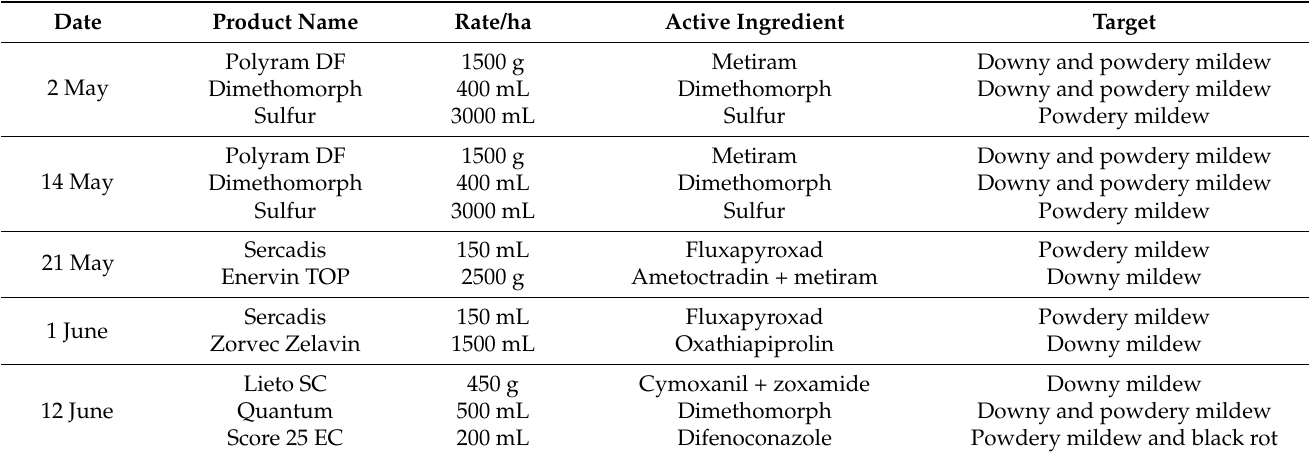
Table 1. Dates, product names, rates, and active ingredients, and target of plant health treatments realized in theVidor vineyard during